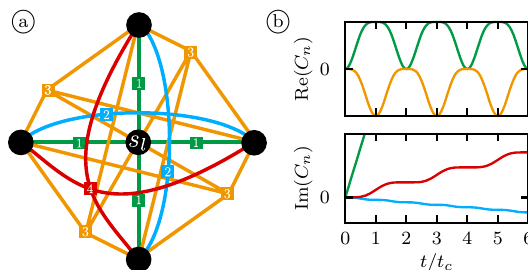
Figure 1: (a) Structure of the perturbative classical network for the TFIM in d = 2 and (b) dynamics of the couplings (color coded as in (a)). The black dots in the network structure represent a classical spin s and its four neighbors in a translationally invariant square l